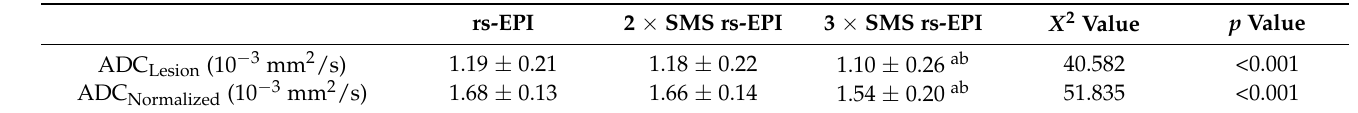
Table 5. The comparison of ADC value between three EPI